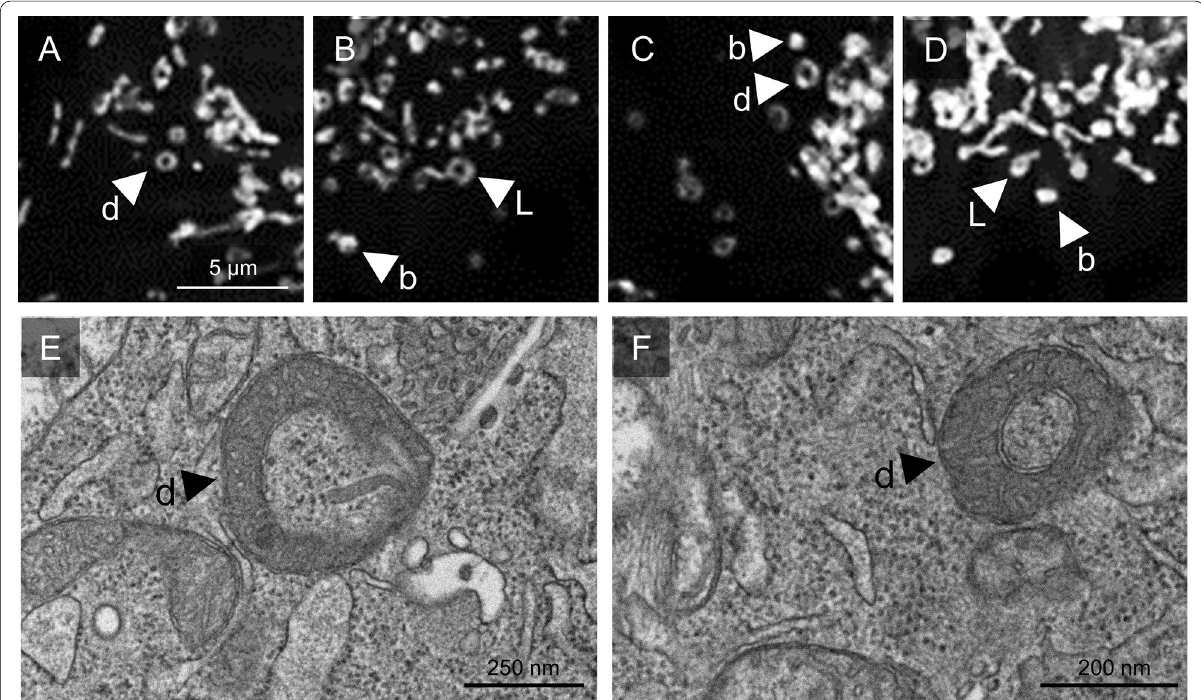
Fig. 4 Unusual morphologies of mitochondria during cold incubation. Cells incubated at 4 °C for 48 h ( A – D ) showed unusual mitochondrial morphologies such as donut (d in A , C ), blob (b in B – D ) or lasso structures (L in B , D ). The images were documented using fluorescence microscopy (λ exc. 546 6 nm, λ em. 590 nm; A – D ). Electron microscopy ( E , F ) confirmed the occurrence of donut-like mitochondrial morphologies (d in E , F ) = ± ≥ already after 6 h of cold